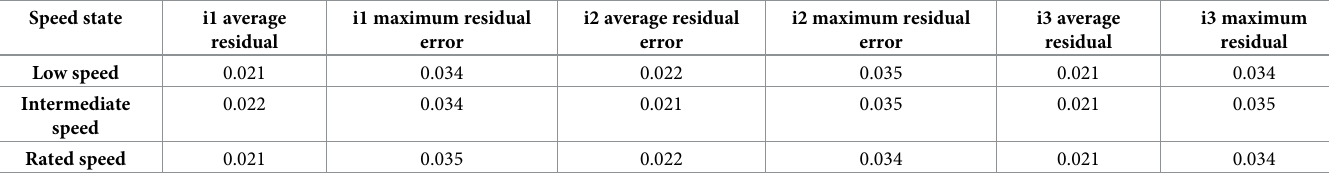
Table 6. Comparison of residual current of each sensor at different